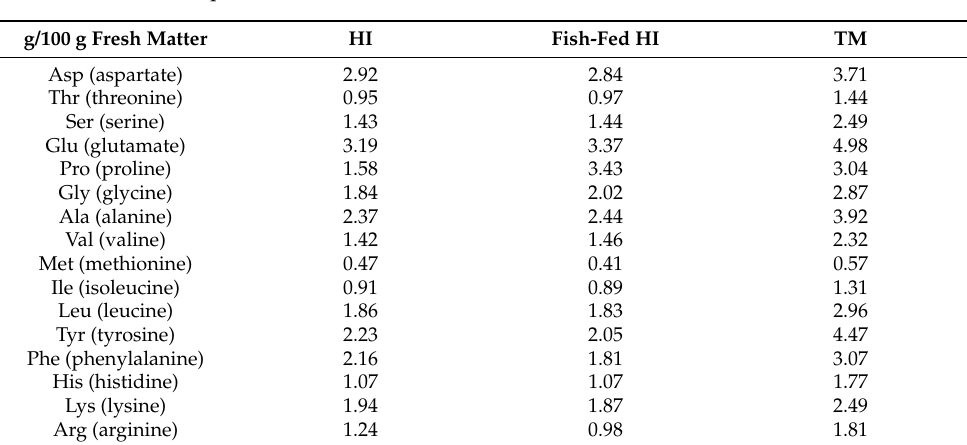
Table 2. Aminoacidic profile of insect